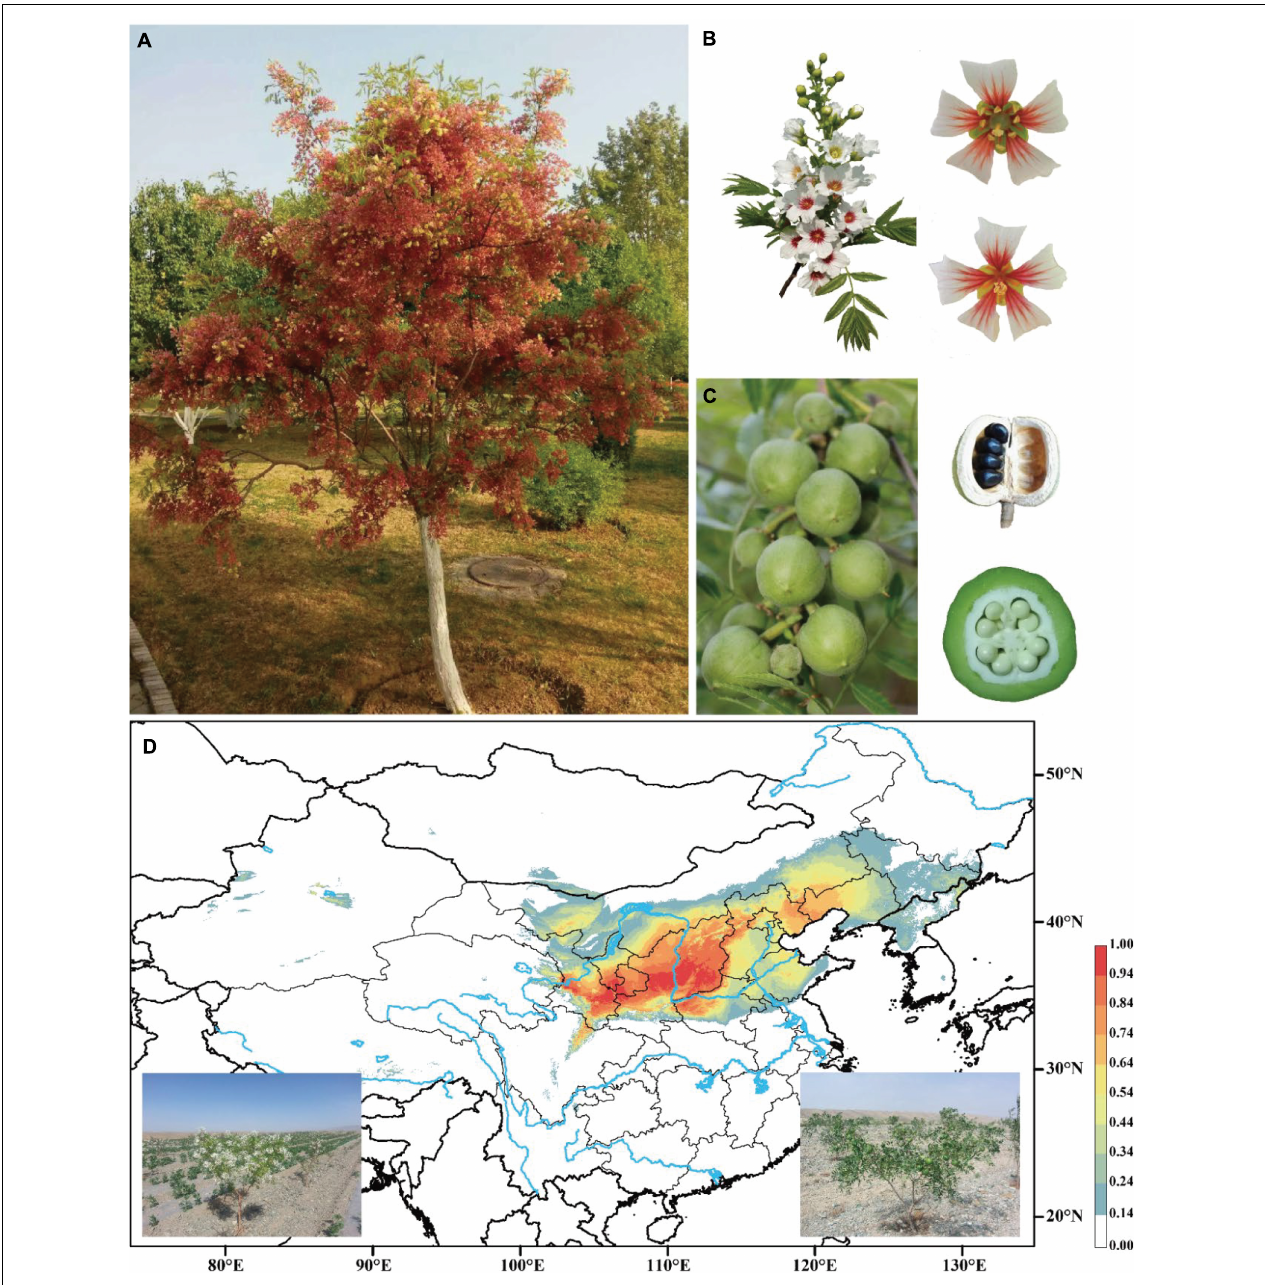
FIGURE 1 | Images of yellowhorn and its potential distribution range. (A) The mature tree (“JGXP”) sampled for genome sequencing. (B) Raceme, hermaphrodite flower (up), and male flower (down). (C) Capsular fruits, seeds in ripe fruit, and cross-section of fruit. (D) Predicted distribution of yellowhorn based on sampled records and current climate data. Images at the bottom are the yellowhorn tree with flowers (left) and fruits (right), respectively.